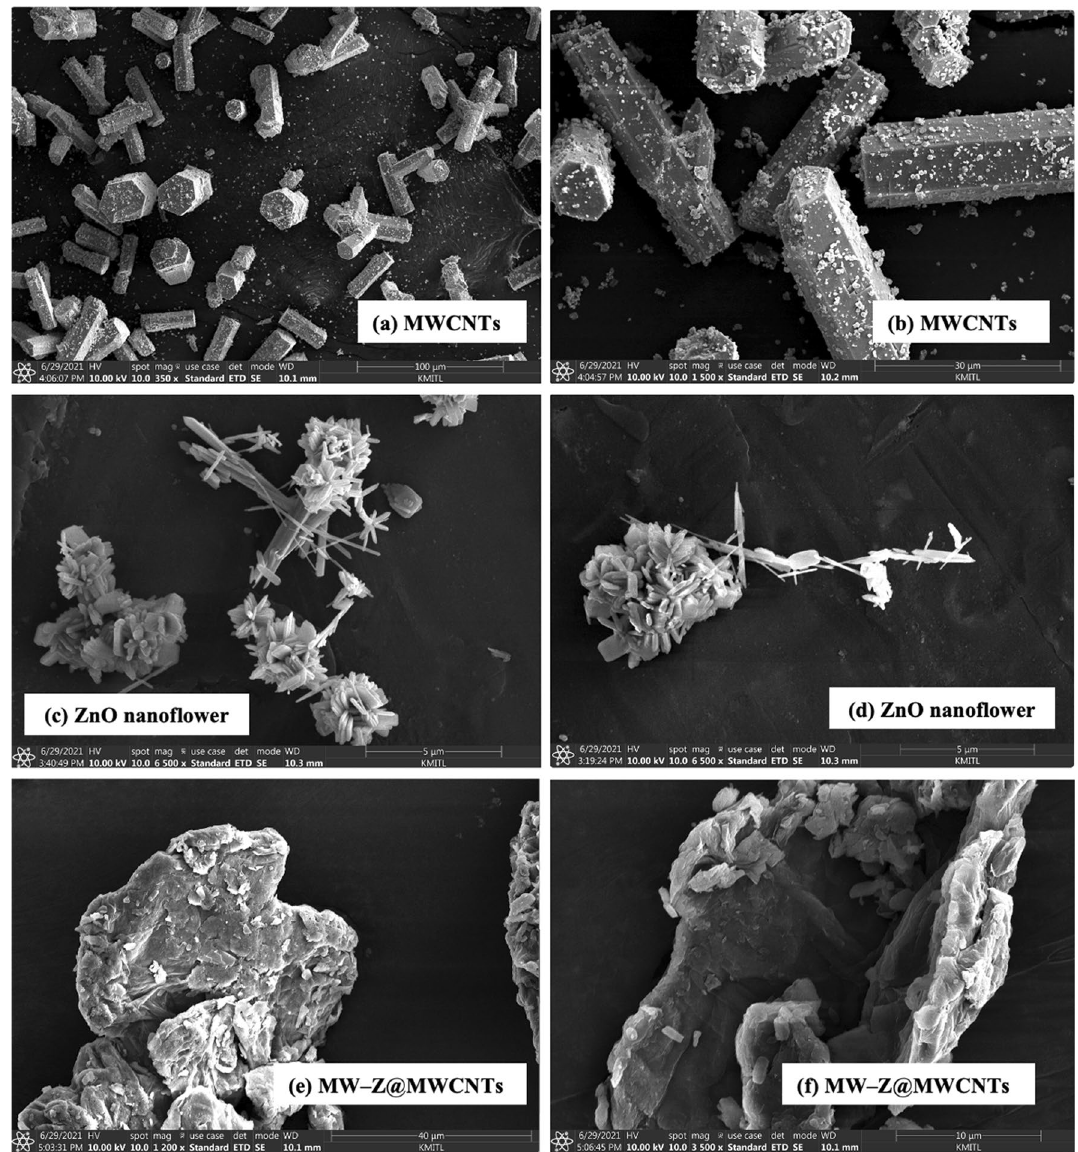
Figure 3. FE-SEM images of ( a,b ) MWCNTs, ( c,d ) ZnO nanoflowers, and ( e,f )